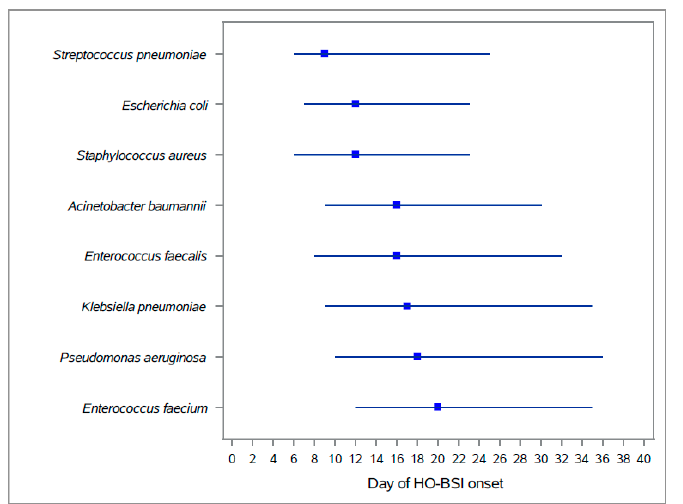
Figure 3. Days from admission to hospital-onset bloodstream infection (HO-BSI) onset, by organism. Square—median; whiskers—interquartile range.